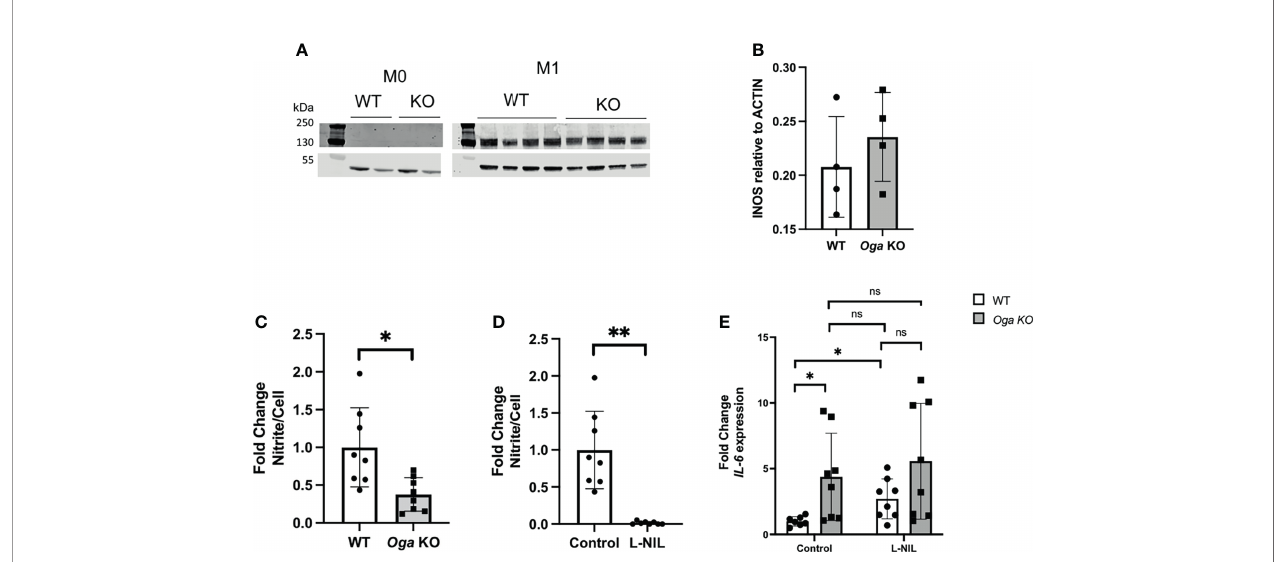
FIGURE 3 | Elevated O -GlcNAc inhibits iNOS function. (A) Representative western blot to assess iNOS protein levels. (B) Quantitation of iNOS protein levels normalized to ACTIN, N = 4. (C, D) Media collected after 24 hours of LPS and IFN- g treatment of BMDMs was used to measure nitrite levels with the Greiss reagent. Levels were normalized to cell number and represented as fold change; (C) assessment of nitrite levels in WT (white bar) and Oga KO (grey bar); (D) assessment of nitrite from WT untreated (control) and L-NIL (iNOS inhibitor) treated WT BMDMs. (E) Il-6 expression was quanti fi ed from cells either treated with L-NIL or left untreated (control) at the time of LPS and IFN- g stimulation from the indicated genotype. Expression was normalized to the geometric mean of Rplp0 and Eef2 and represented as fold change. Error bars represent standard deviations. N = 8. *p < 0.05 **p < 0.01, ns, not signi fi cant as determined by student ’ s